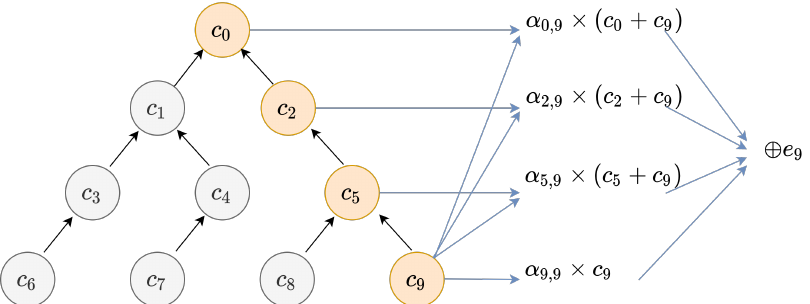
Figure 5. A sample construction of the medical ontology